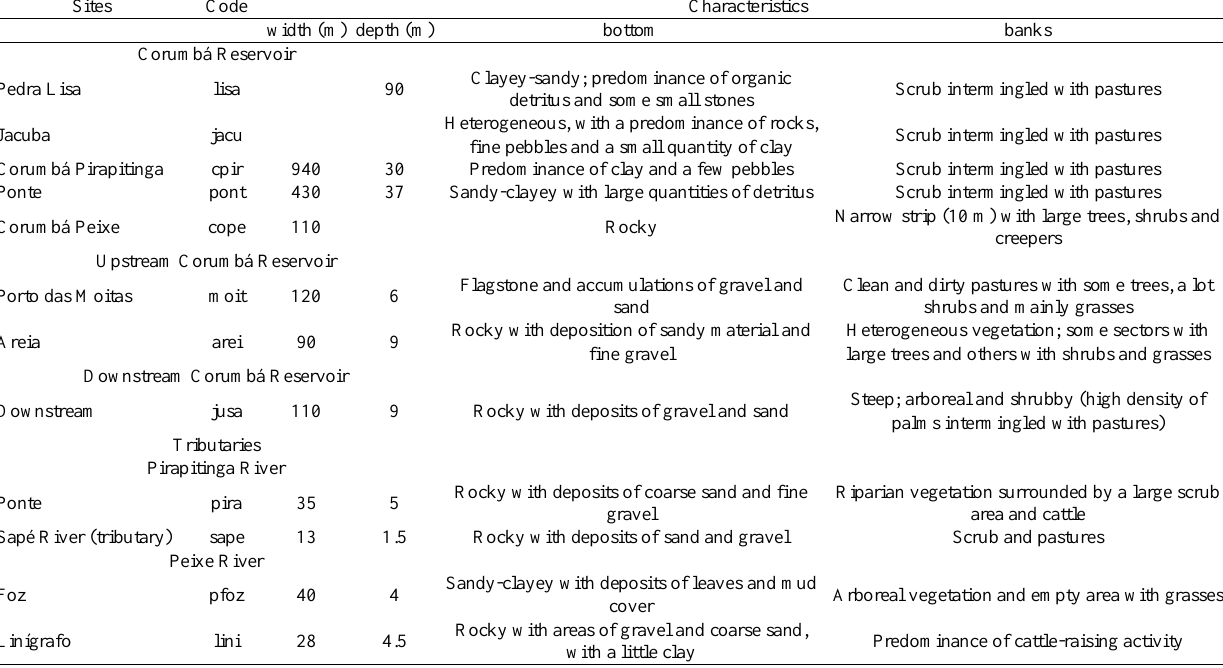
Table 1 . Morphometric and physiographic characteristics of the sampling